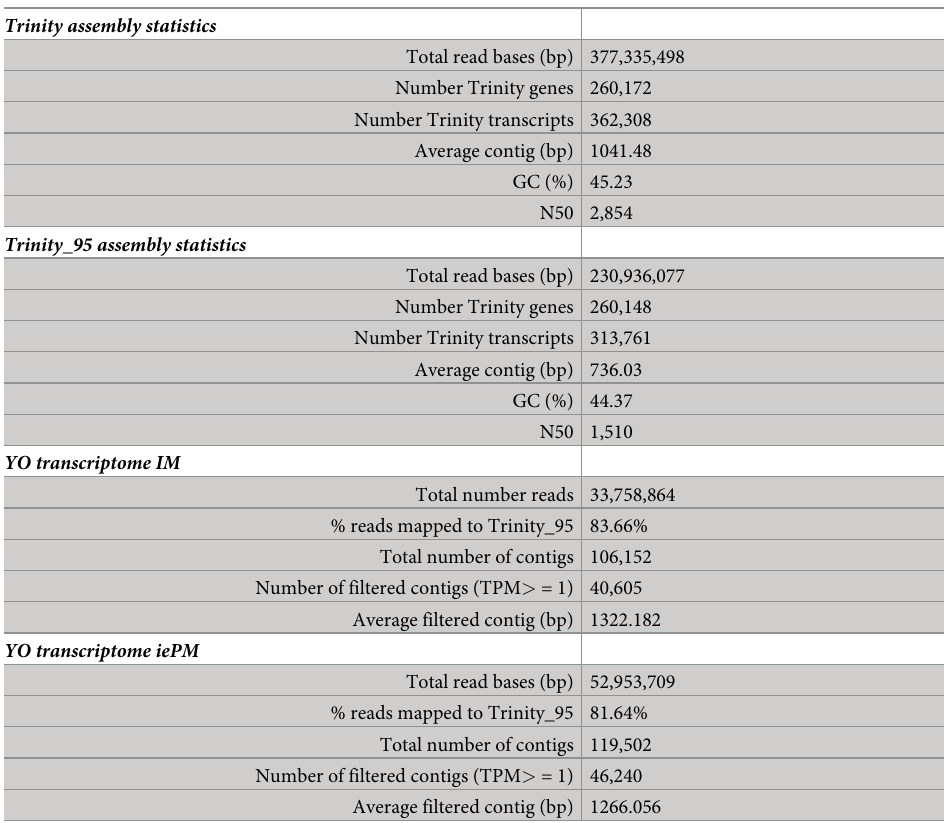
Table 3. Summary of Illumina sequencing statistics and mapping.